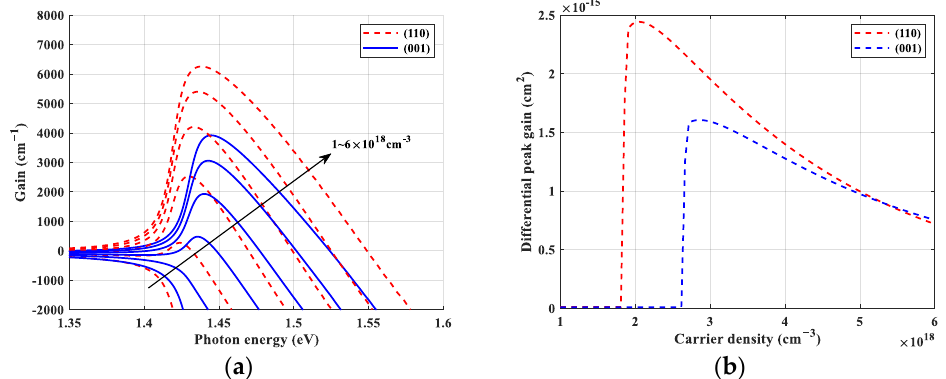
Figure 7. Calculated ( a ) gain spectra and ( b ) differential gain for (001) and (110)-oriented strained QW lasers.